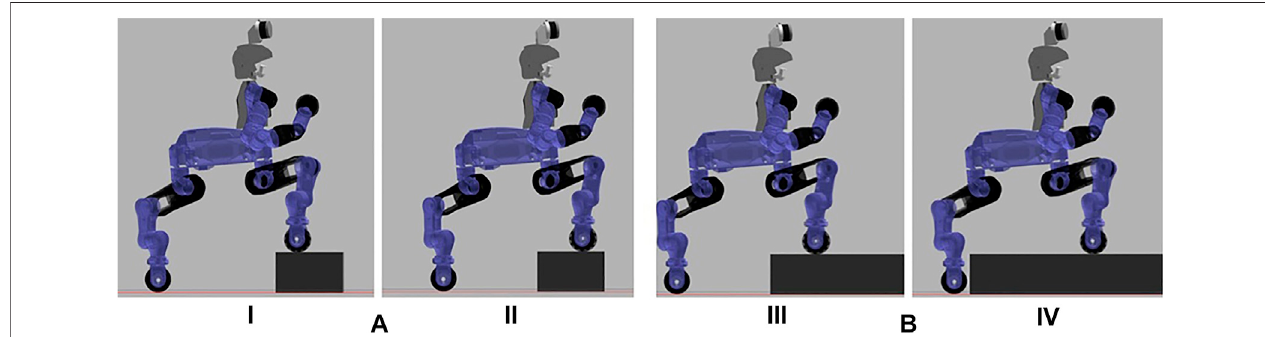
FIGURE9| Differenceinthesteppingonapproachaftersteppingonwiththefrontwheels: (A) Frontwheelsaremuchclosertotheendoftheobjectratherthanthe rearwheelswiththebeginningoftheobstacle.Therobotstepsonwiththefrontwheels(I)anddriveuntilthefrontwheelsreachtheendoftheobstacle(II).Atthispointthe robot will step down with the front wheels before considering the stepping on with the rear ones. (B) The opposite case, in which the robot has to step on with the front wheels (III) and drive until the rear wheels will be close to the object (IV). At this point the robot will step on also with the rear wheels.